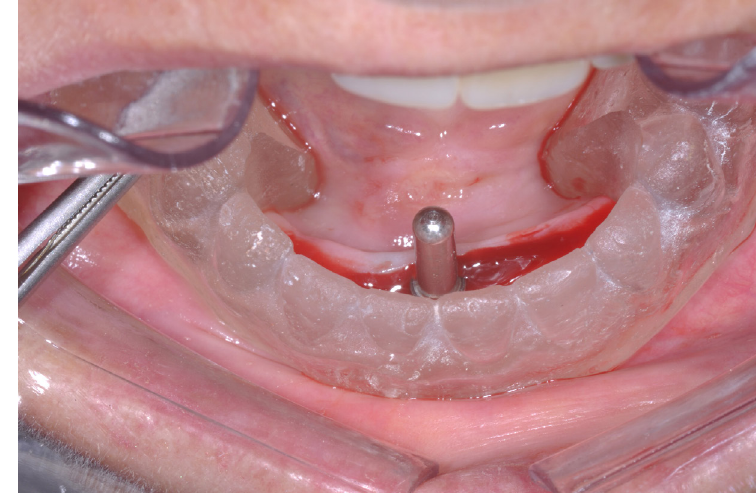
Figure 2- Implant positioner and surgical guide (GI)